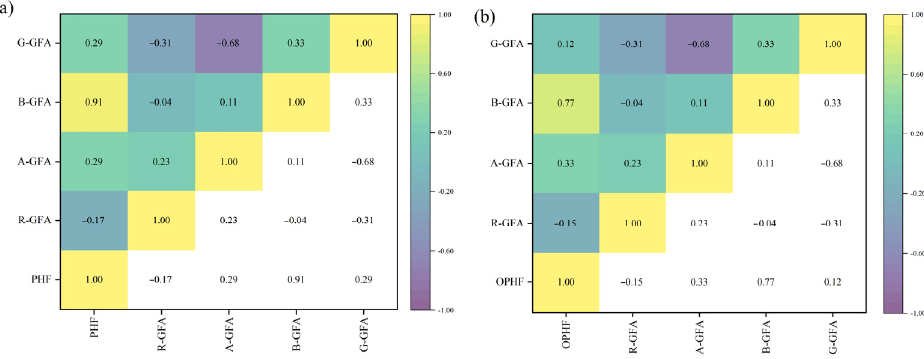
Figure 8. Correlations at business sites, ( a ) peak periods; ( b ) off-peak periods. .